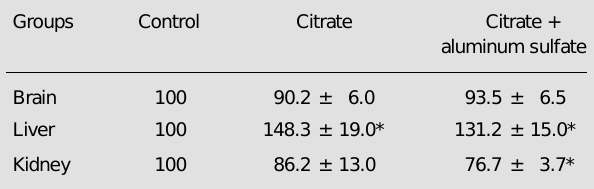
Table 2 - In vivo effect of aluminum sulfate on delta-aminolevulinic acid dehydratase (ALA-D) from brain, liver and kidney of adult mice. Data are reported as mean ± SEM for at least five animals per group. *P<0.05 compared to control (Duncan test). ALA-D activity is re- ported as percent of control. The control enzyme activities were 32 ± 2.7 in brain, 211 ± 26 in liver, and 88 ± 14 in kidney, reported as nmol porphobilinogen h -1 mg protein -1 .